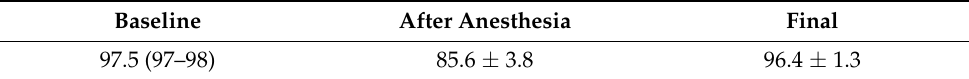
Figure 4. Box plot representation of the variability of cerebral oximetry (INVOS 3100 system, So- manetics Corp ® Medtronic, Minneapolis, MN, USA). Values expressed in the table as mean and standard deviation. Table 2. Values of bispectral index monitor during surgery (bilateral BIS, A-2000TM Version 3.4; Aspect Medical System Inc., Norwood, MA, USA). Values expressed in the table as mean and standard deviation for normal variables and median and range for non-normal ones.